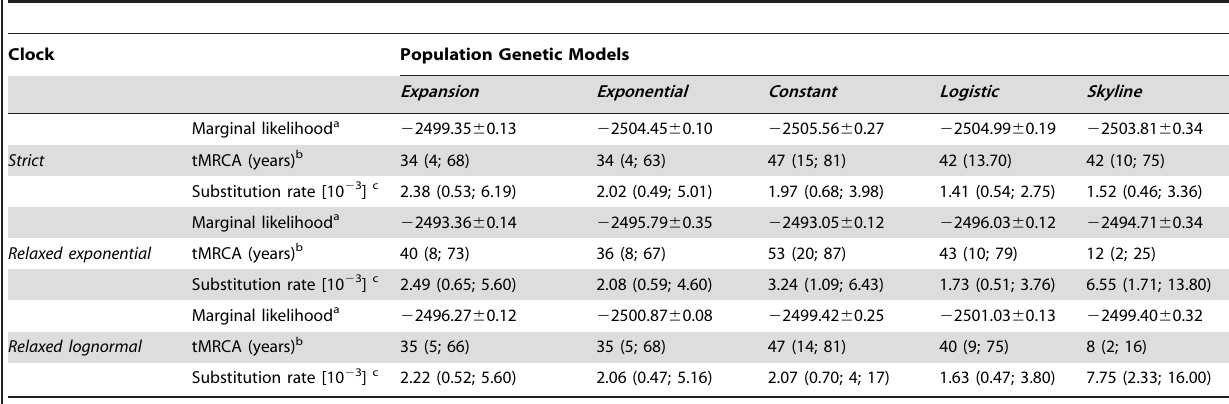
Table 5. Estimates of the substitution rate and the tMRCA for the NS5B gene by Bayesian coalescent methods under several molecular clock and population genetic